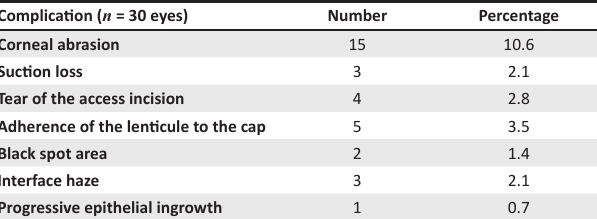
FIGURE 4: ‘Efficacy’ distribution of uncorrected visual acuity at 1 and 24 months. Pre-operative corrected distance visual acuity versus post-operative uncorrected distance visual acuity – Percentage. TABLE 2: Complications of small-incision lenticule extraction